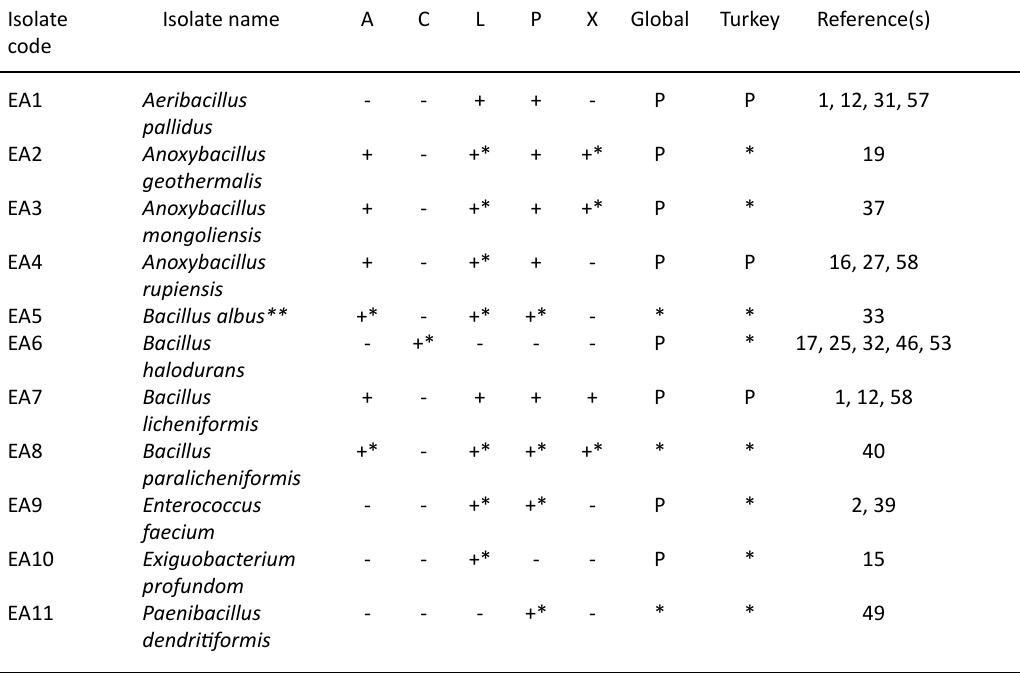
Table 3. Industrial enzyme production profiles of the isolates and their first investments in thermophilic regions